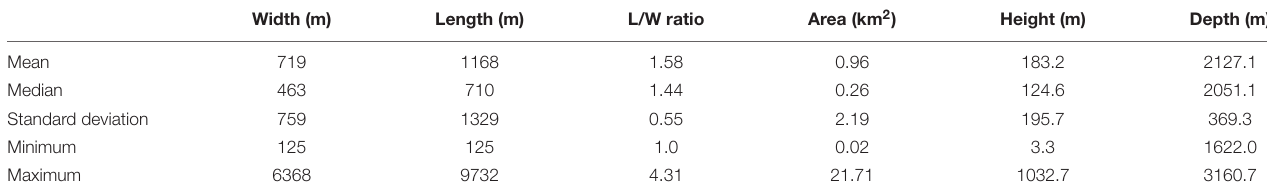
TABLE 2 | Main morphological characteristics of the 198 Orphan Knoll mounds, measured from the DY081 multibeam sonar survey. Width (m) Length (m) L/W ratio Area (km 2 ) Height (m) Depth